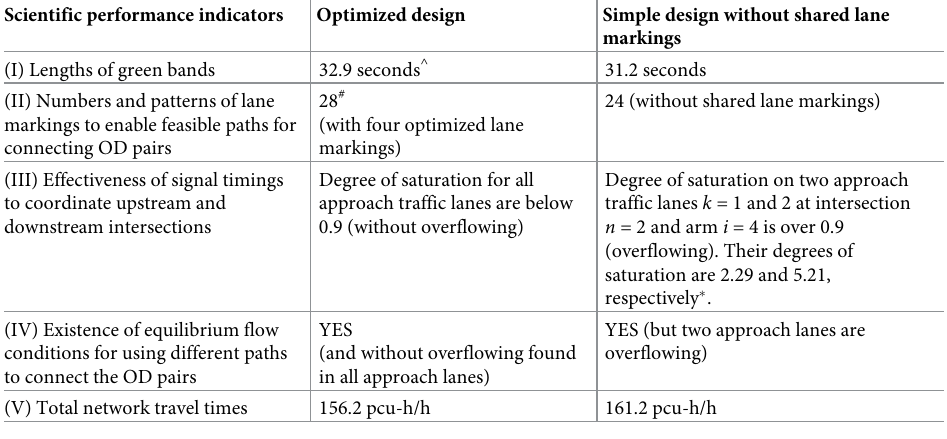
Scientific performance